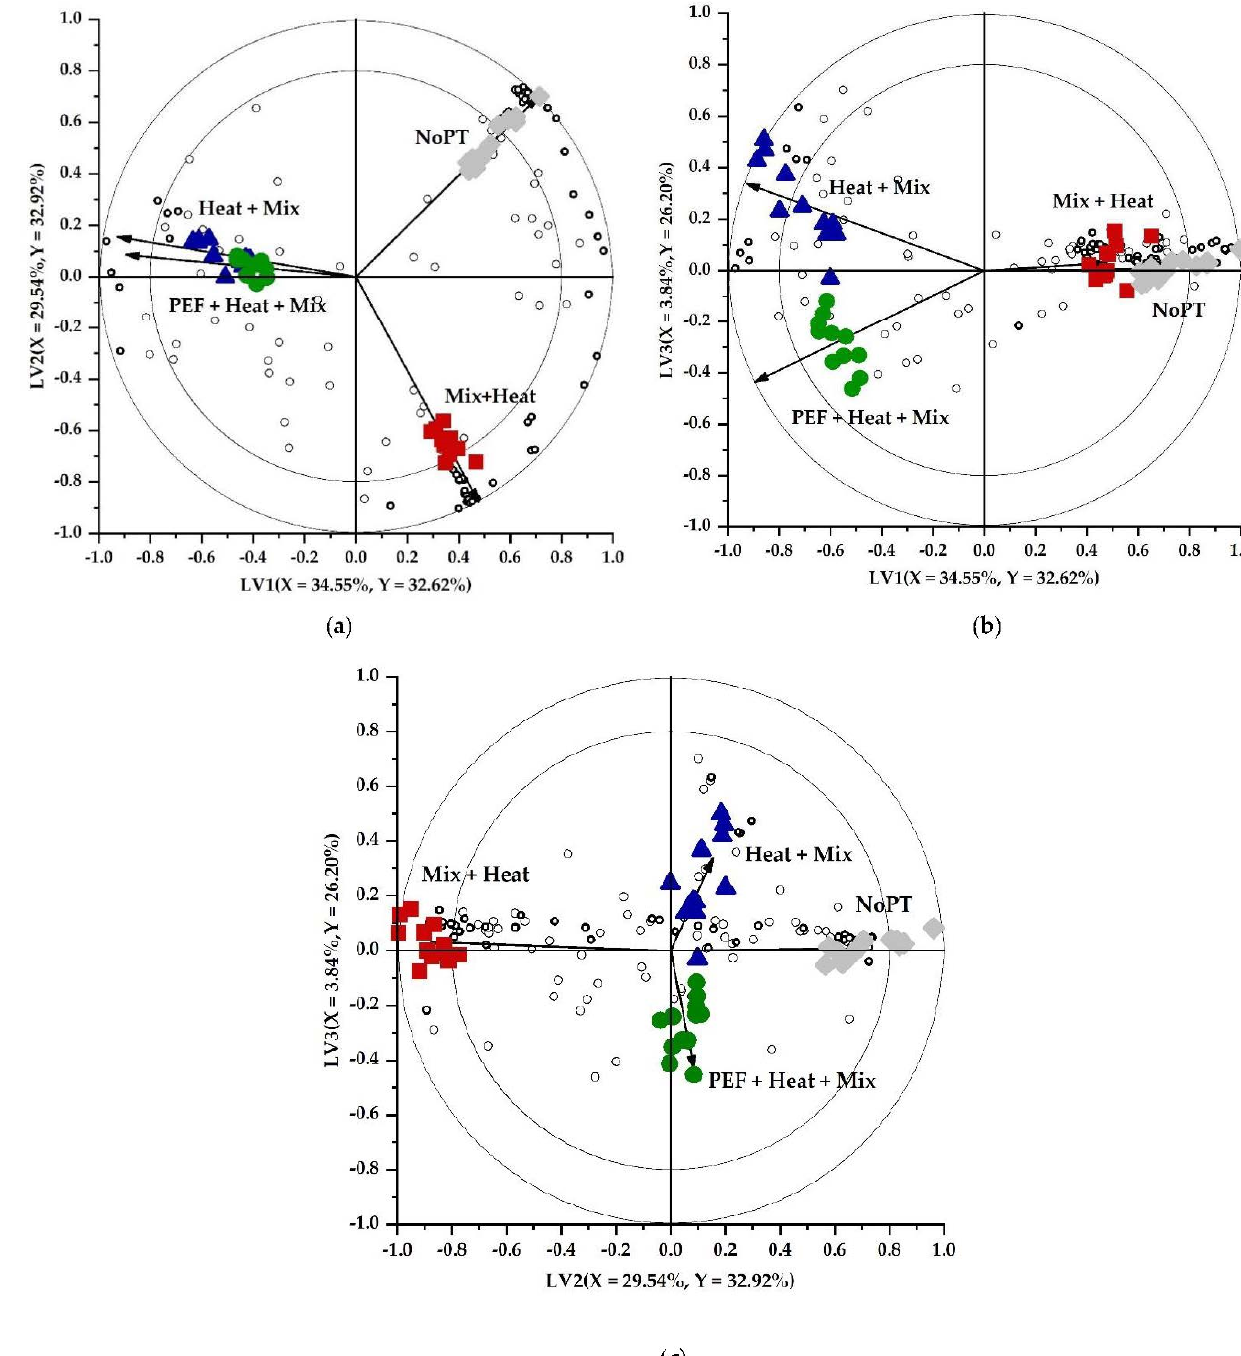
Figure 1. PLS ‐ DA biplots visualizing the effect of pretreatment ((  ) No pretreatment (NoPT), (  ) Figure 1. PLS-DA biplots visualizing the effect of pretreatment ((  ) No pretreatment (NoPT), (  ) Figure 1. PLS-DA biplots visualizing the effect of pretreatment No pretreatment Figure 1. PLS-DA biplots visualizing the effect of pretreatment ((  ) No pretreatment (NoPT), (  ) Figure 1. PLS-DA biplots visualizing the effect of pretreatment ((  ) No pretreatment (NoPT), (  ) Figure 1. PLS-DA biplots visualizing the effect of pretreatment ((  ) No pretreatment (NoPT), (  ) Mix + Heat, (  ) PEF + Heat + Mix, and (  ) Heat + Mix) on the volatile profile of Brussels sprouts. Mix + Heat, (  ) PEF + Heat + Mix, and (  ) Heat + Mix) on the volatile profile of Brussels sprouts. Mix + Heat, (  ) PEF + Heat + Mix, and (  ) Heat + Mix) on the volatile profile of Brussels sprouts. Mix + Heat, (  ) PEF + Heat + Mix, and (  ) Heat + Mix) on the volatile profile of Brussels sprouts. Mix + Heat, (  ) PEF + Heat + Mix, and (  ) Heat + Mix) on the volatile profile of Brussels sprouts. Heat + Mix) on the volatile profile of Brussels sprouts. Open circles (o) on the biplots represent the headspace components with the discriminant compo ‐ Open circles (o) on the biplots represent the headspace components with the discriminant compo- Open circles (o) on the biplots represent the headspace components with the discriminant compo- Open circles (o) on the biplots represent the headspace components with the discriminant compo- Open circles (o) on the biplots represent the headspace components with the discriminant compo- Open circles (o) on the biplots represent the headspace components with the discriminant components nents marked in bold (|VID| ≥ 0.800) ( o ). Vectors depict the correlation loadings for the categorical nents marked in bold (|VID| ≥ 0.800) ( o ). Vectors depict the correlation loadings for the categorical nents marked in bold (|VID| ≥ 0.800) ( o ). Vectors depict the correlation loadings for the categorical nents marked in bold (|VID| ≥ 0.800) ( o ). Vectors depict the correlation loadings for the categorical nents marked in bold (|VID| ≥ 0.800) ( o ). Vectors depict the correlation loadings for the categorical marked in bold (|VID| ≥ 0.800) ( o ). Vectors depict the correlation loadings for the categorical 𝑌 ‐ variables. The variance explained by each LV is indicated in the respective axes. The inner and 𝑌 -variables. The variance explained by each LV is indicated in the respective axes. The inner and 𝑌 -variables. The variance explained by each LV is indicated in the respective axes. The inner and 𝑌 -variables. The variance explained by each LV is indicated in the respective axes. The inner and 𝑌 -variables. The variance explained by each LV is indicated in the respective axes. The inner and Y -variables. The variance explained by each LV is indicated in the respective axes. The inner and outer circles depict the correlation coefficients of 0.8 and 1.0, respectively. ( a ) LV2 as a function of outer circles depict the correlation coefficients of 0.8 and 1.0, respectively. ( a ) LV2 as a function of outer circles depict the correlation coefficients of 0.8 and 1.0, respectively. ( a ) LV2 as a function of outer circles depict the correlation coefficients of 0.8 and 1.0, respectively. ( a ) LV2 as a function of outer circles depict the correlation coefficients of 0.8 and 1.0, respectively. ( a ) LV2 as a function of outer circles depict the correlation coefficients of 0.8 and 1.0, respectively. ( a ) LV2 as a function of LV1; LV1; ( b ) LV3 as a function of LV1; ( c ) LV3 as a function of LV2. LV1; ( b ) LV3 as a function of LV1; ( c ) LV3 as a function of LV2. LV1; ( b ) LV3 as a function of LV1; ( c ) LV3 as a function of LV2. LV1; ( b ) LV3 as a function of LV1; ( c ) LV3 as a function of LV2. LV1; ( b ) LV3 as a function of LV1; ( c ) LV3 as a function of LV2. ( b ) LV3 as a function of LV1; ( c ) LV3 as a function of